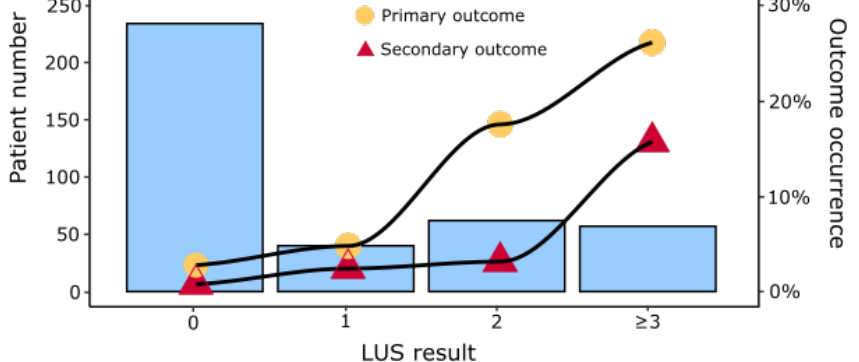
Figure 2. Patient number and primary and secondary outcome occurrence in patients stratified by LUS results.